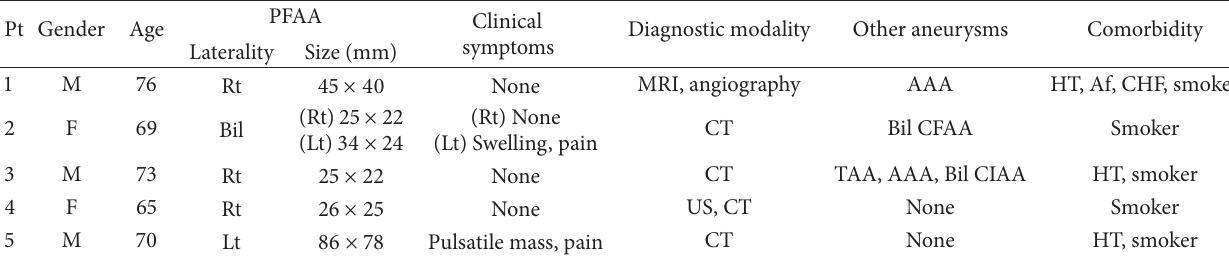
Table 1: Patients characteristics.